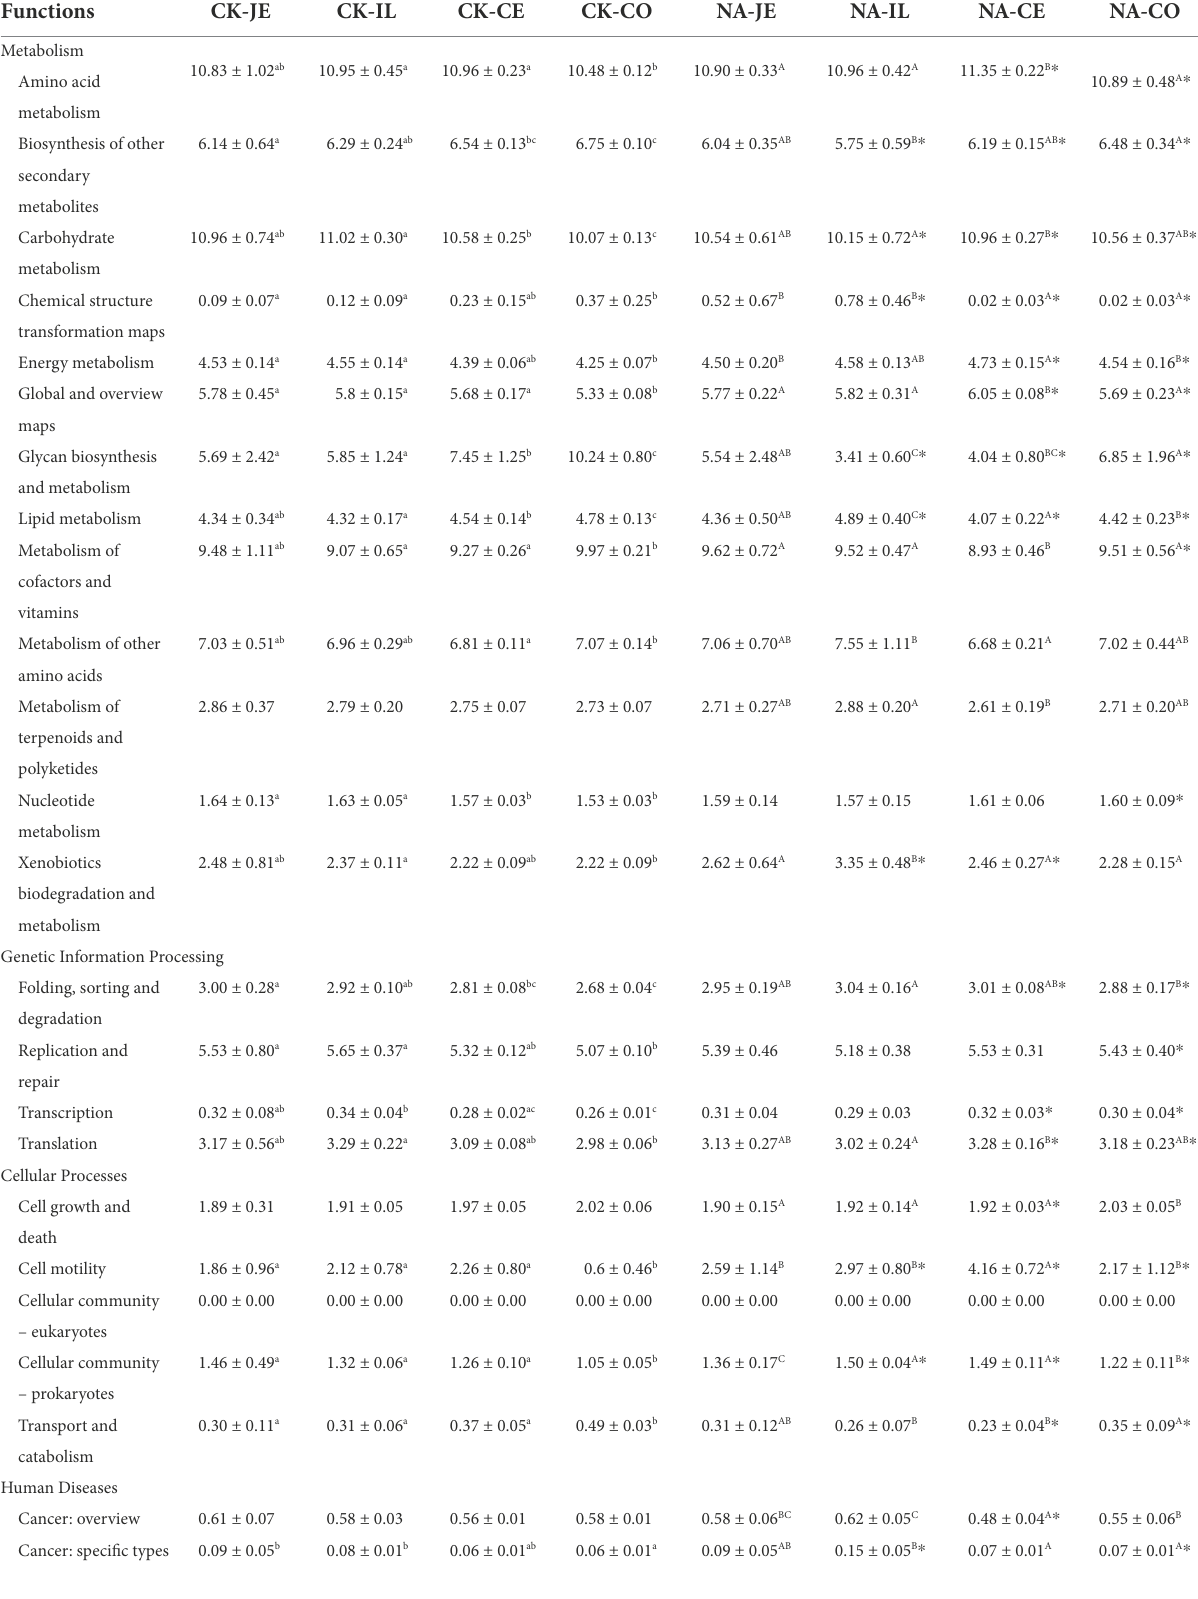
TABLE 2 Relative abundance of secondary functional genes in gut microbiota of normal and NAFLD